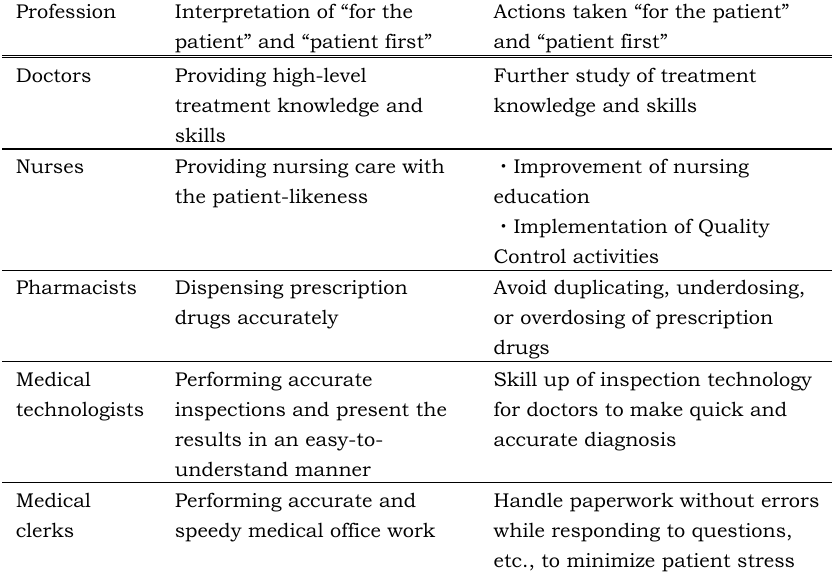
Table 1. Recognition and action taken by each